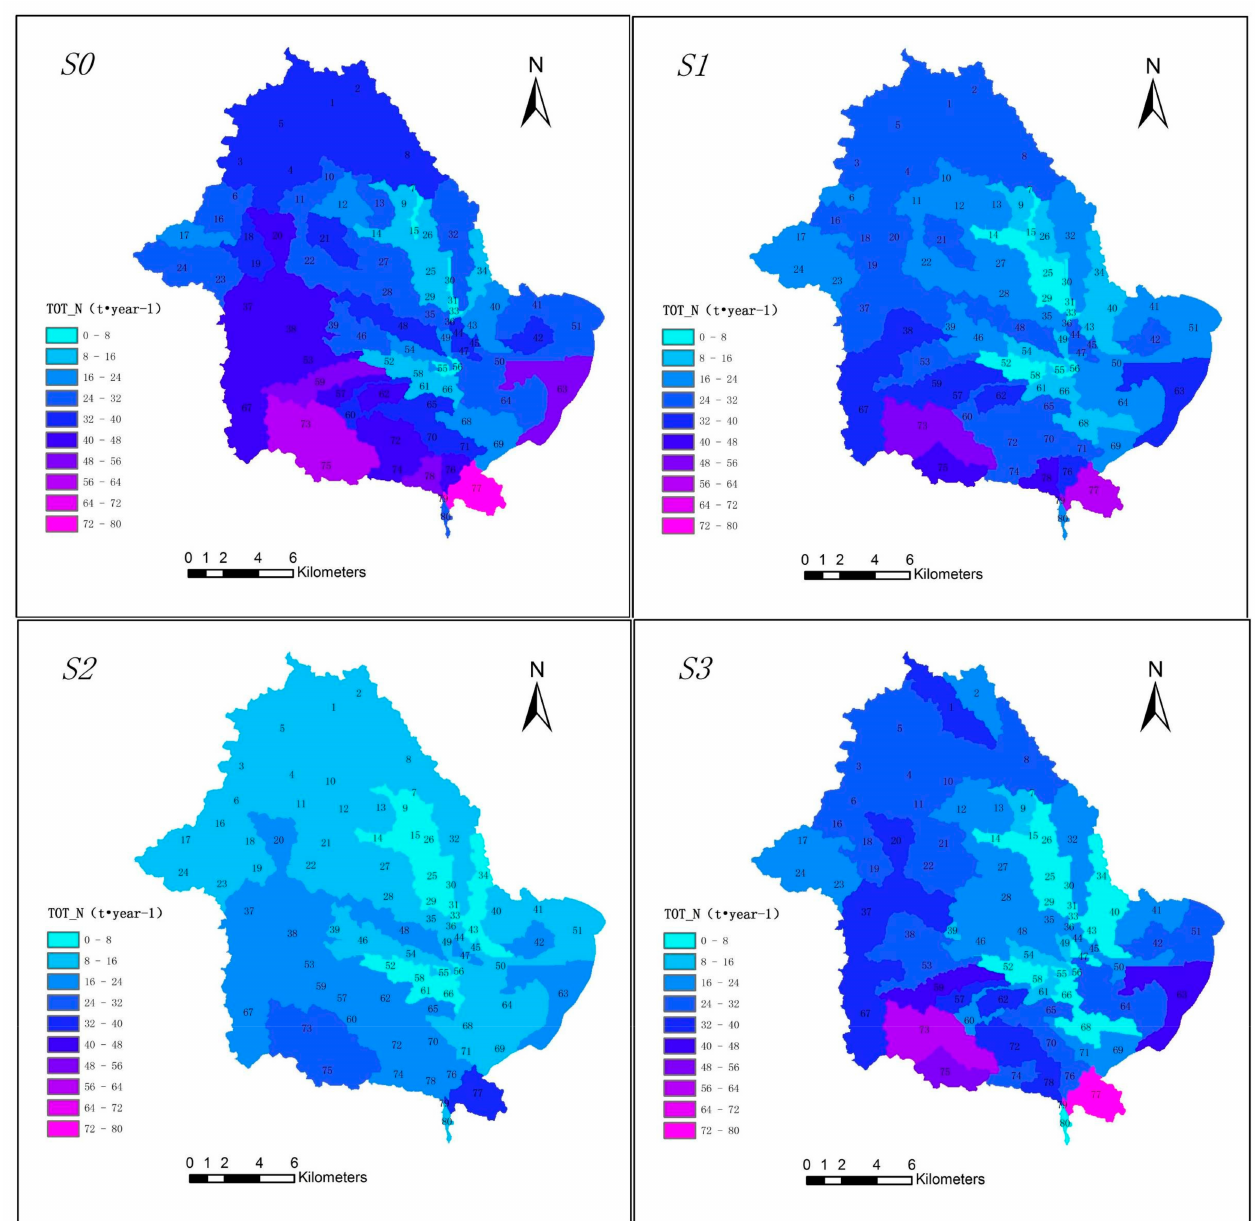
Figure 10. Spatial distribution of TOT_N loss in MLW under different scenarios. S0: current situation; S1: halving fertilization every year; S2: fallow every other year; S3: returning agricultural land to